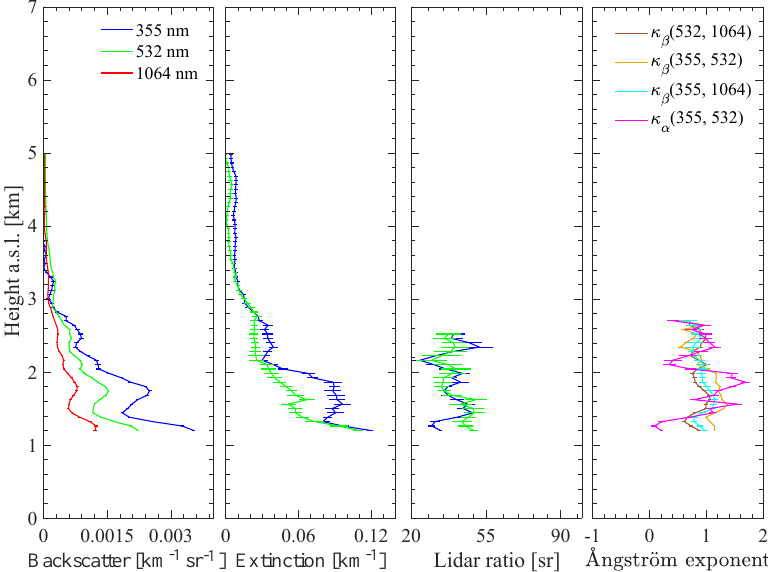
Figure 8. Optical profiles measured at Athens, on 22 May 2014, 20:28–21:28UTC with a multi-wavelength Raman lidar. The error bars correspond to the standard deviation. The effective resolution of the extinction coefficient profiles varied from 240 to 780m using the method described in Pappalardo et al. (2004b).